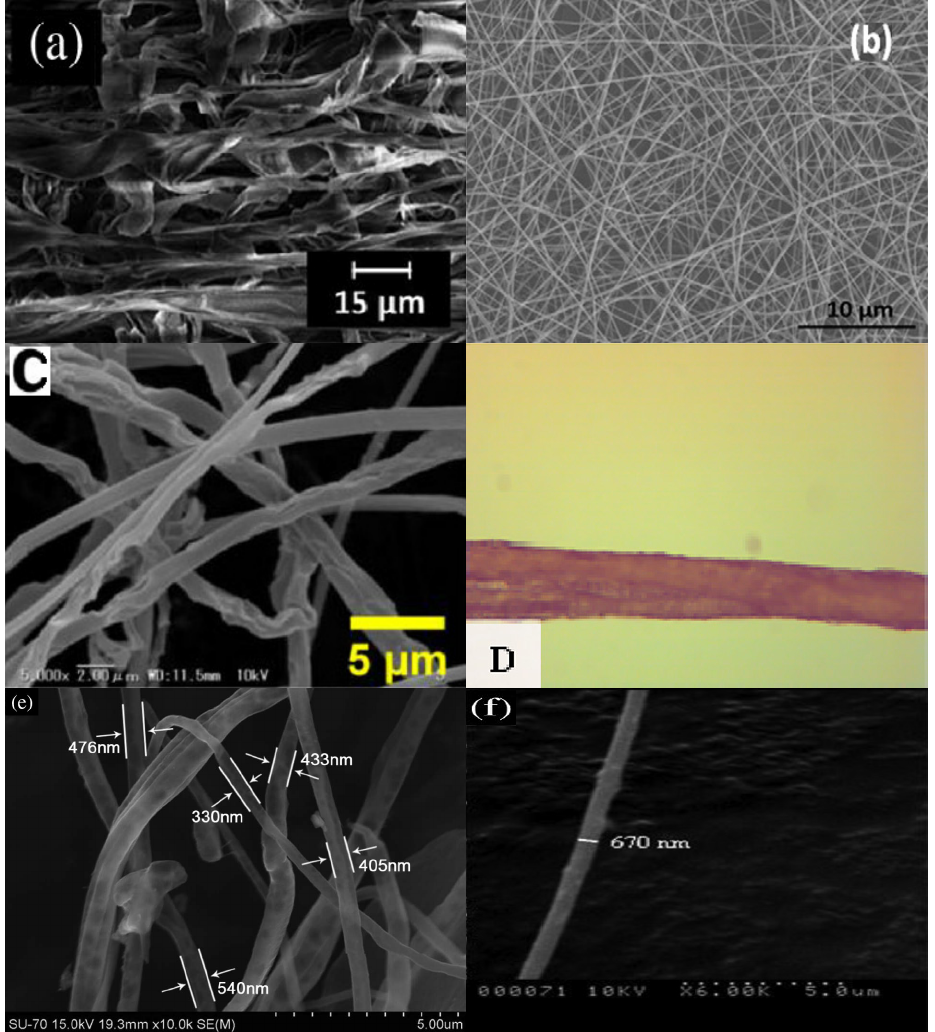
Figure 5. SEM micrographs of ( a ) electrospun cellulose fibers [6]; ( b ) electrospun silk fibers [36]; ( c ) electrospun cellulose fibers [14]; ( d ) electrospun chitin/PLA blend fiber [29]; ( e ) electrospun cellulose fibers [7]; and ( f ) electrospun chitin fiber [1] assisted by different ionic liquids as solvents.